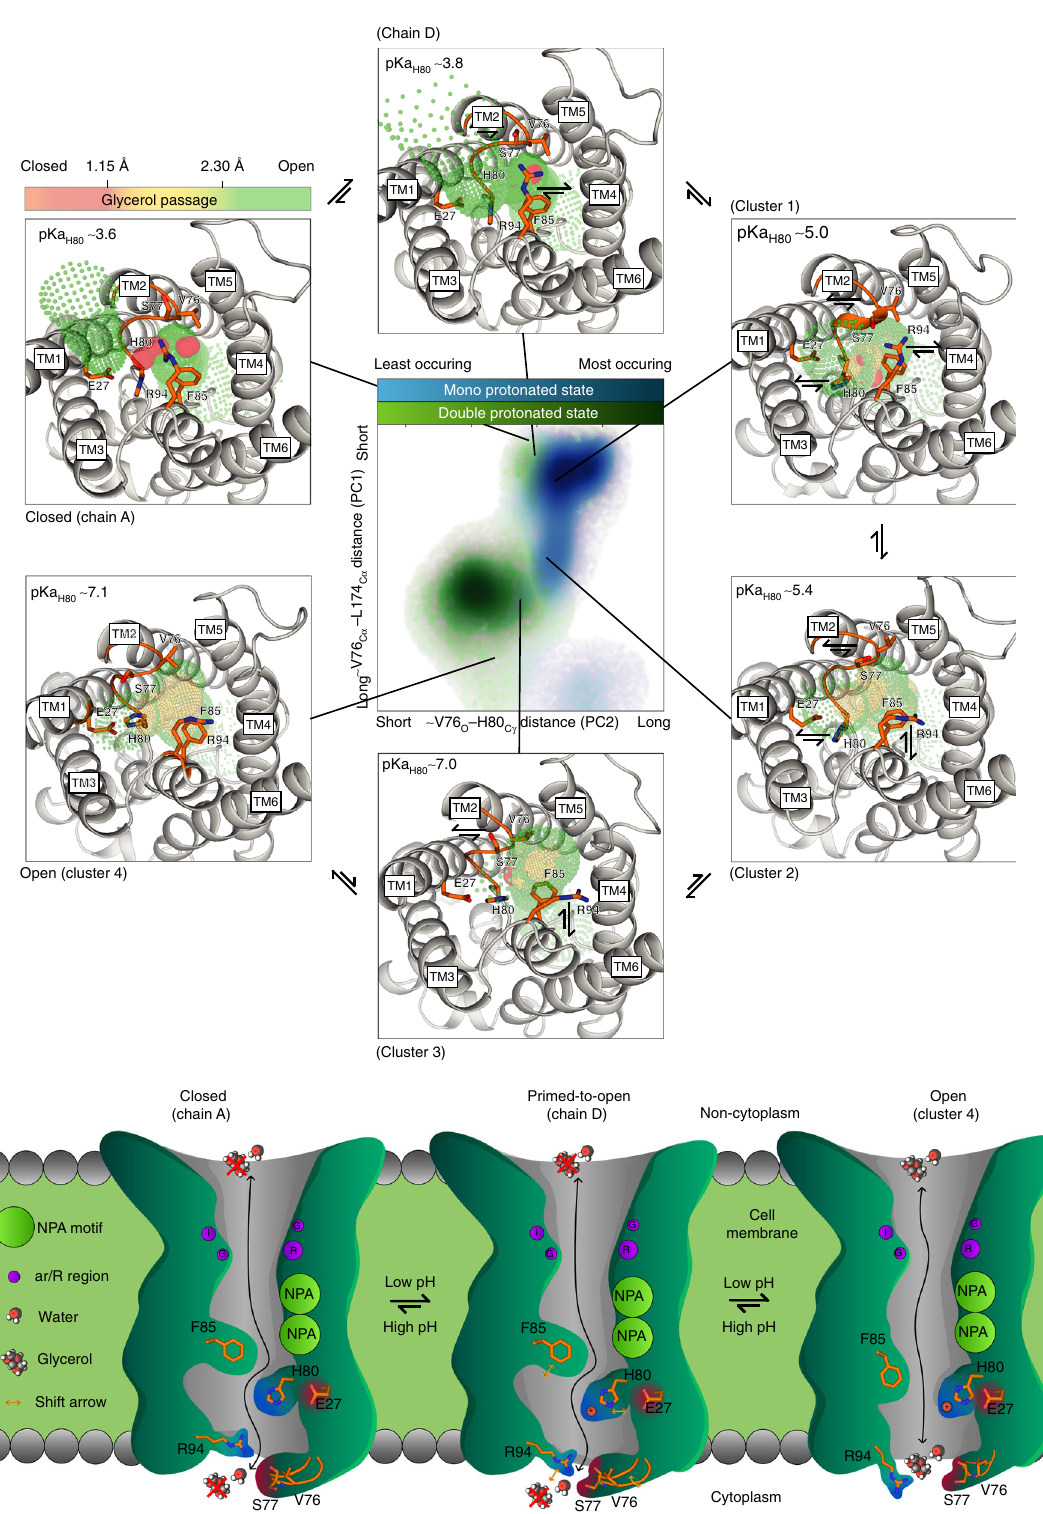
carbonyl cyanide-4-(tri fl uoromethoxy) phenylhydrazone (FCCP, Sigma, USA) to equilibrate the intracellular pH with the extracellular medium. After 5-min incubation at 20 °C, the end-point fl uorescence was measured as indicated above. Measurements of glycerol release into the media were determined for the corresponding hormonal treatments described above. Brie fl y, freshly isolated human adipocytes were washed twice and resuspended with non-buffered isotonic mannitol followed by 20-min incubation at 20 °C. Subsequently, cells were